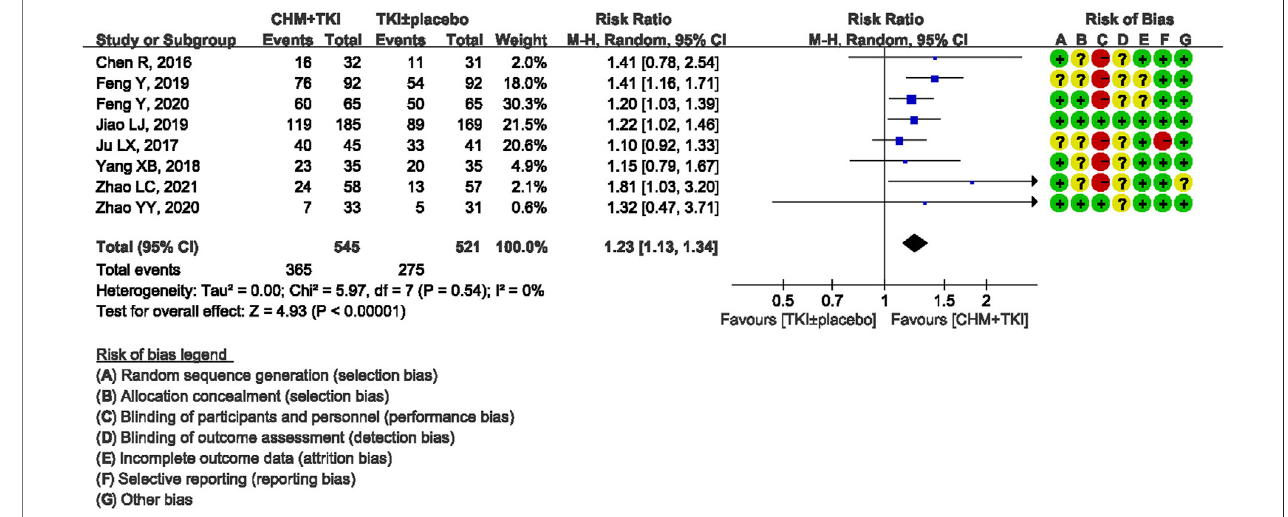
FIGURE 4 | Forest plot showing ORR.